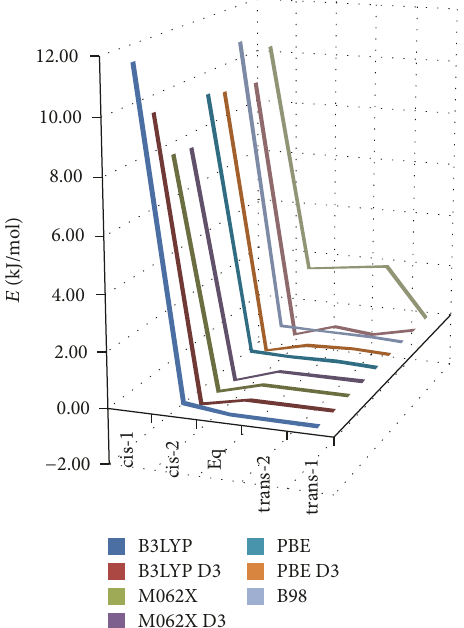
Figure 3: Trends in relative energies (unit: kJ/mol) for five isomers computed as single-point calculations at all different levels of DFT/ 6-31G(d, p)//B3LYP/6-31G(d, p) and MP2/def2-TZVPP//B3LYP/6- 31G(d,